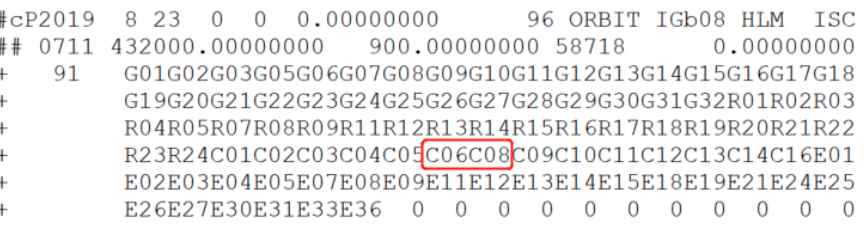
Figure 8. The header of the precise orbit products published by iGMAS and WHU on 23 August 2019.